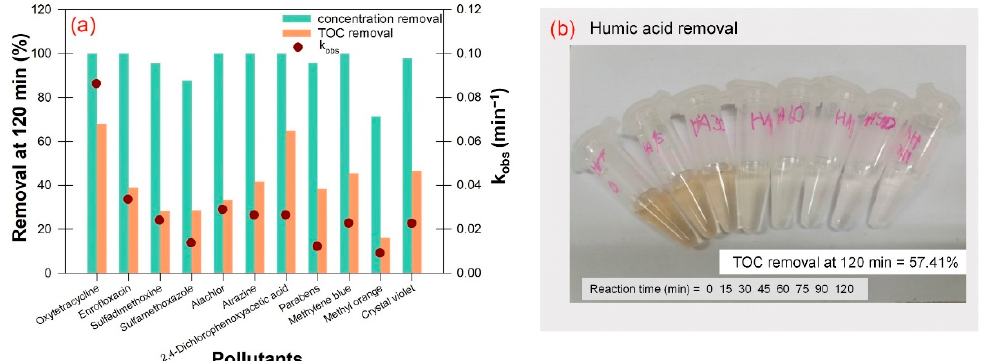
Figure 4. ( a ) The organic pollutant removal efficiencies and their observed kinetic rate constants (k obs ), and ( b ) the removal of 100 mg/L humic acid using Cu 0.5 Mn 0.5 Fe 2 O 4 /H 2 O 2 /light system (Conditions: [H 2 O 2 ] = 97.89 mM, catalyst loading = 0.5 g/L, [pollutant] 0 = 0.1 mM).